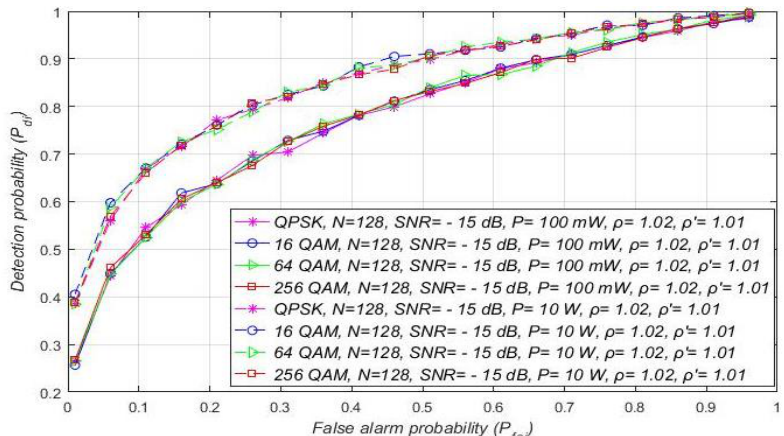
Figure 8. Interdependence between detection and false alarm probability for ED of signals in MA systems transmitted with two Tx powers and four different OFDM modulations.